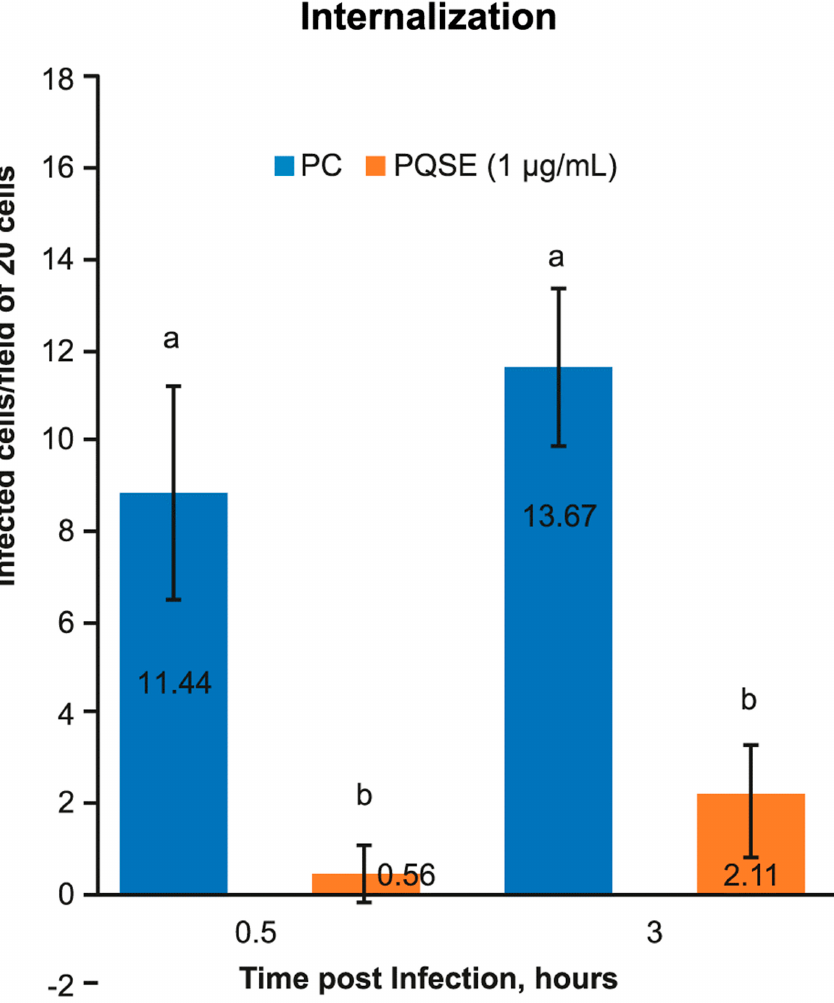
Figure 4. Internalization of P. salmonis in SHK-1 cells pre-incubated 4 h with 0.5 µ g/mL of Quillaja saponaria Extract (PQSE). The internalization test for P. salmonis in SHK-1 cells, showed a significant reduction in the number of cells infected with the bacterium in the groups pre-incubated with PQSE, either, at 0.5 hpi (early internalization) as a 3 hpi (late internalization), with respect to the Positive Control (PC) (cells infected with P. salmonis). The test considered, two (2) treatments (PQSE & PC), three (3) repetitions/treatment, sixty (60) cells/repetition. The statistical analysis was performed using a Manova, to evaluate, time and treatments, independent variables. Different letters, a and b represent statistical differences at p <